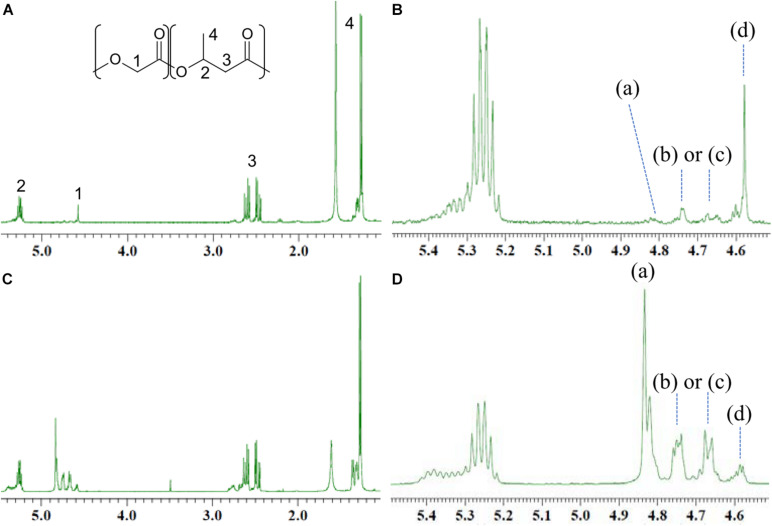
1H NMR analysis of the GL-based copolymers containing 11 mol% GL synthesized by PhaC1PsSTQK (A,B) and 40 mol% GL synthesized by PhaCAR
(C,D).